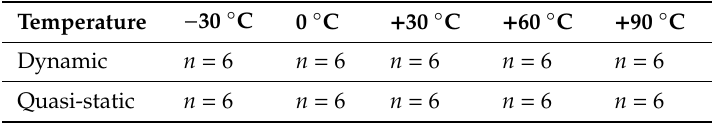
Table 1. Matrix of the conducted experiments at different temperatures ranging from nominally −30 °C to +90 °C for dynamic and quasi-static bending tests.